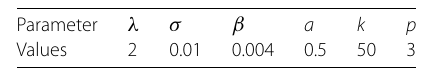
Table 1 Values of the working parameters